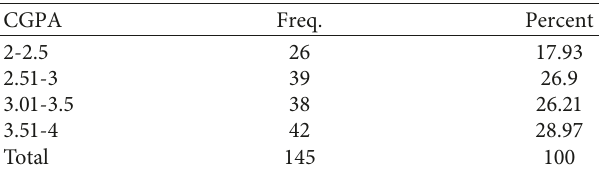
Table 4: Distribution of respondents by CGPA category. CGPA